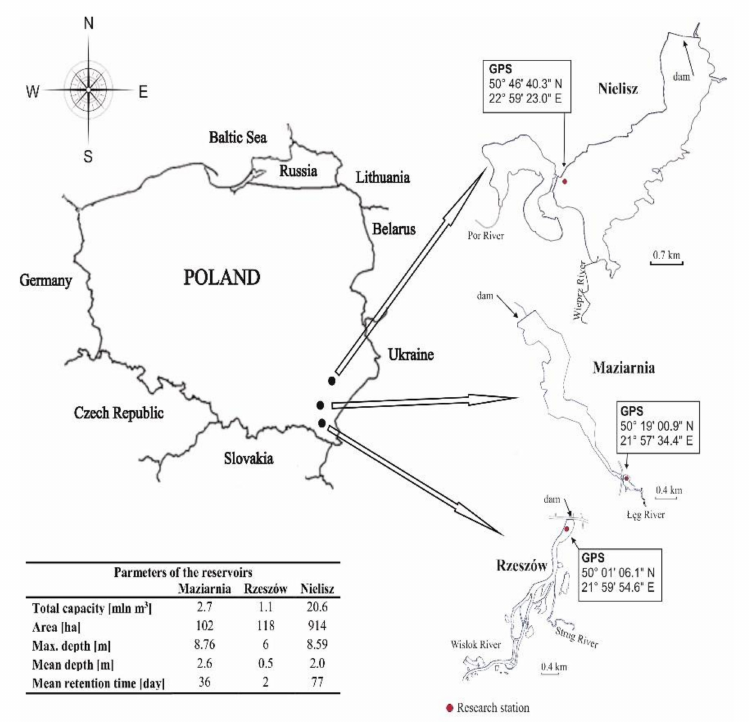
Figure 1. Location of studied reservoirs and sampling